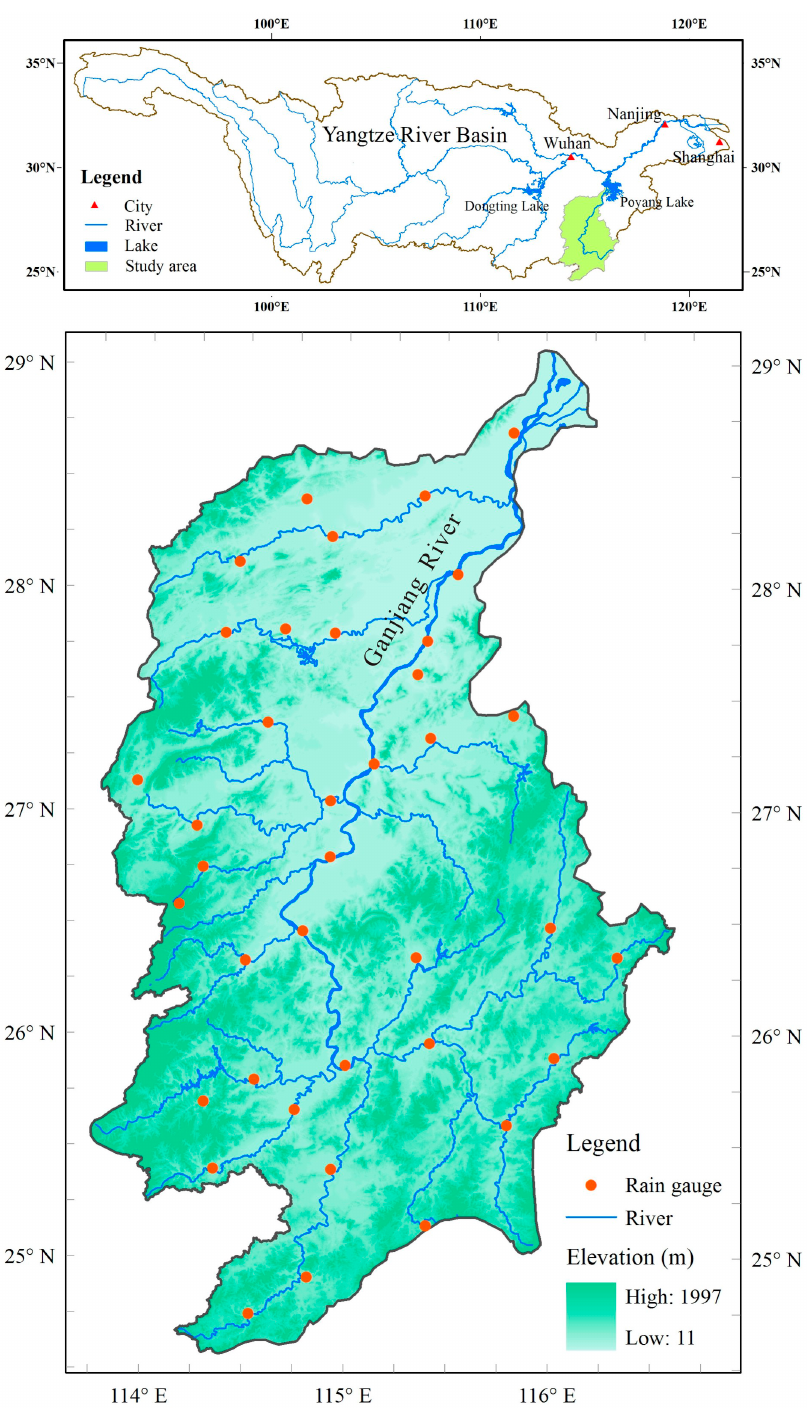
Figure 1. Location of the study area and the distribution of stations.